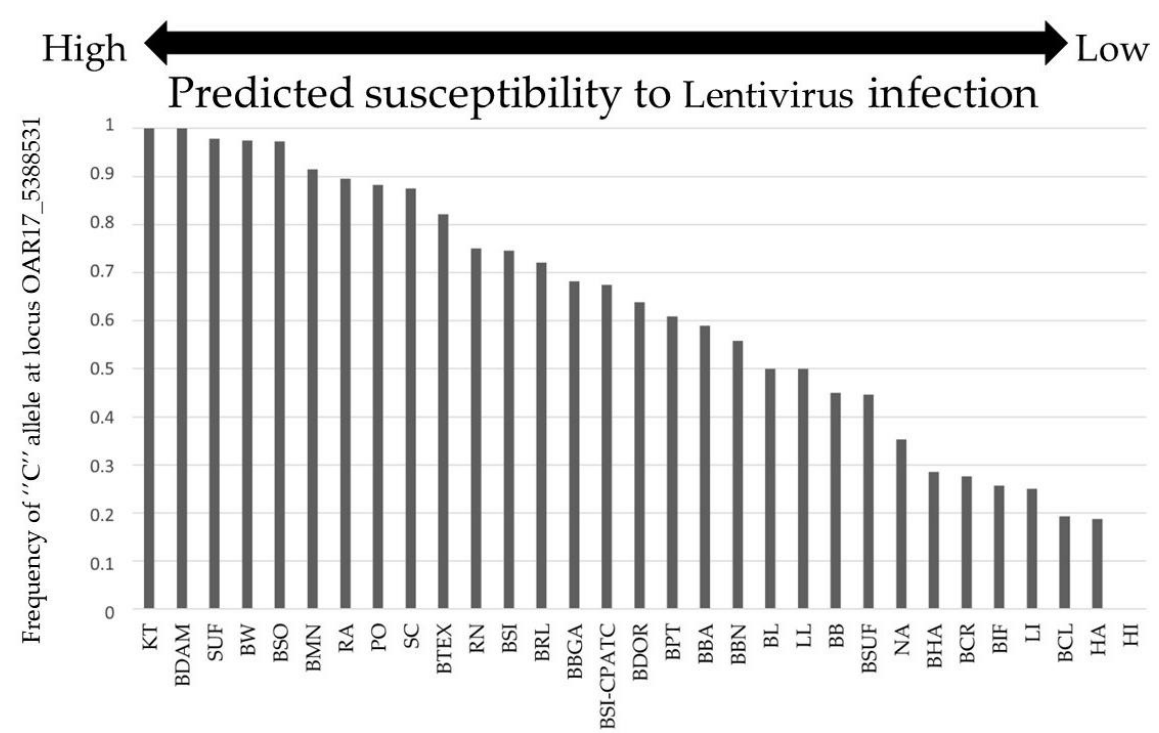
Figure 1. Frequency of the allele “ C ” at the locus OAR17_5388531 in Brazilian and North American sheep breeds. The “ C ” allele is in LD with the “ G ” allele in the codon 35 (GAA) of the TMEM154